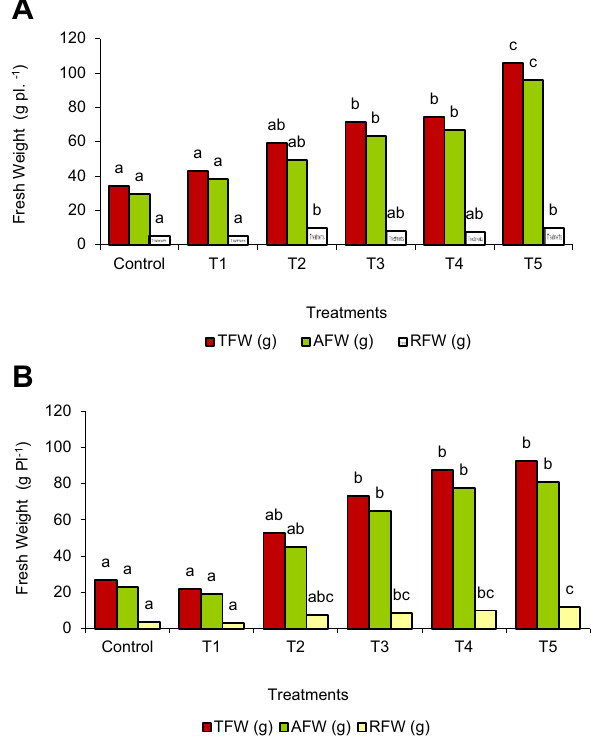
Fig. 1 Effect of different compost and mineral fertilizer dosages over the fresh weight of pot-planted lettuce. a First year, b second year. TFW total fresh weight, AFW aerial fresh weight, RFW root fresh